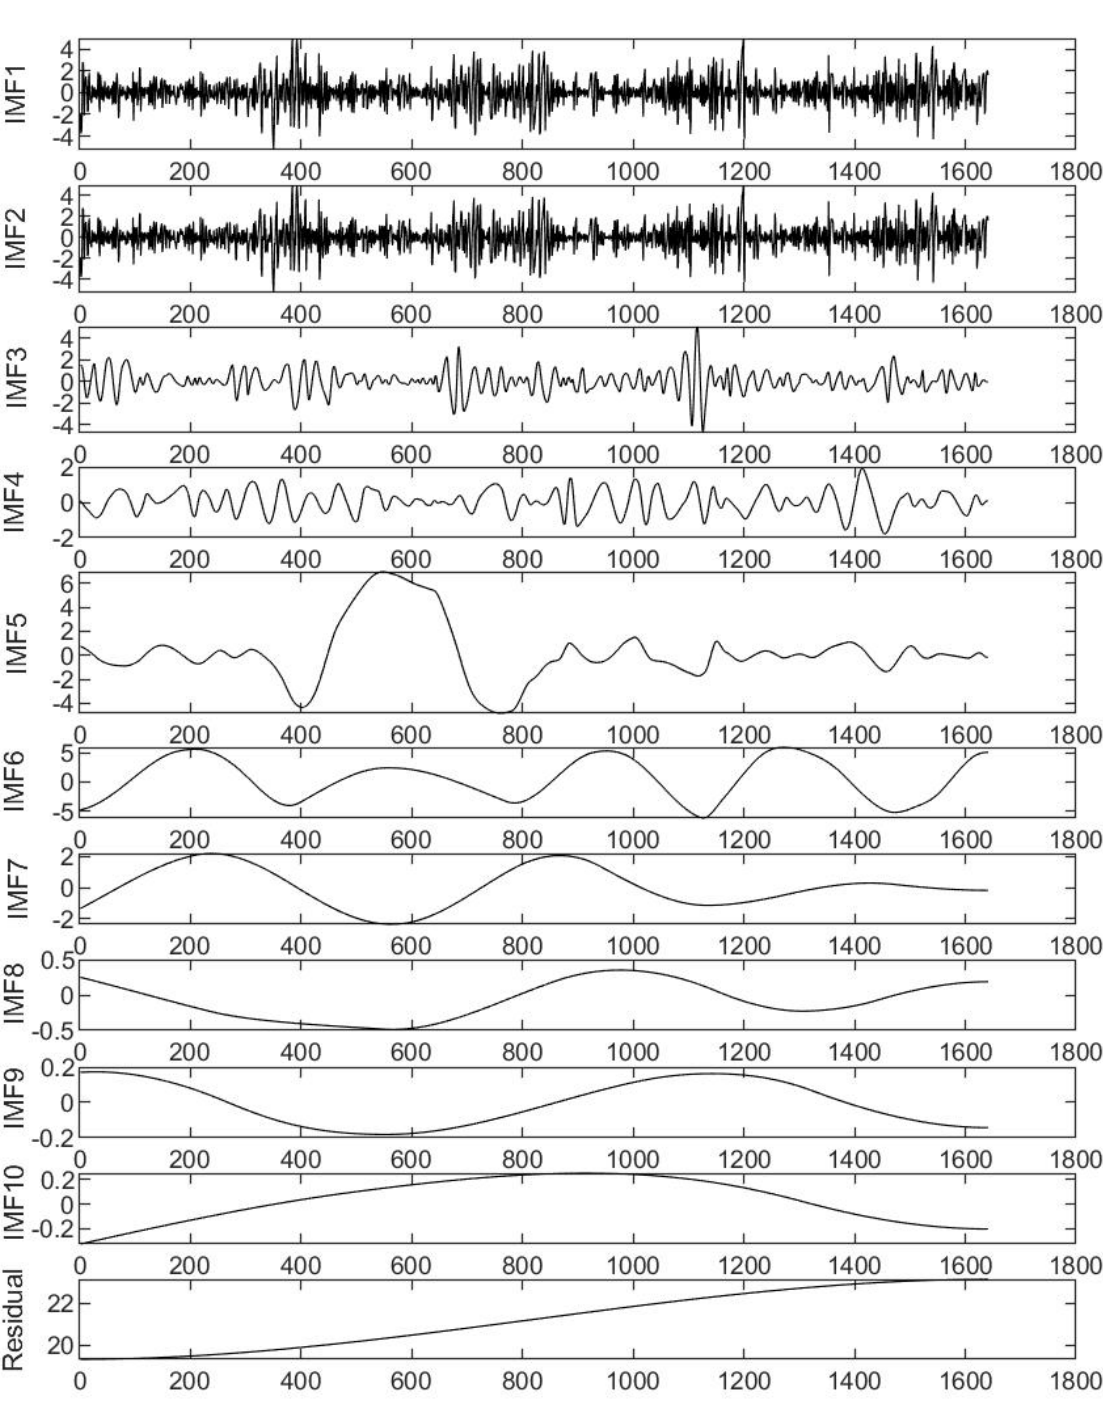
Figure 5. Daily minimum temperature of the EMD decomposition. As shown in Table 2, the correlation coefficients between the original sequence of the lowest temperature and IMF6 and IMF5 reached 0.822 and 0.510, indicating that these two components had a great relationship with the original sequence. Therefore, two indexes IMF6 and IMF5 were selected from all the components and then combined with the remaining original indexes and input into the LSTM model to forecast the minimum temperature with multiple variables. All other features are the same as the minimum temperature prediction